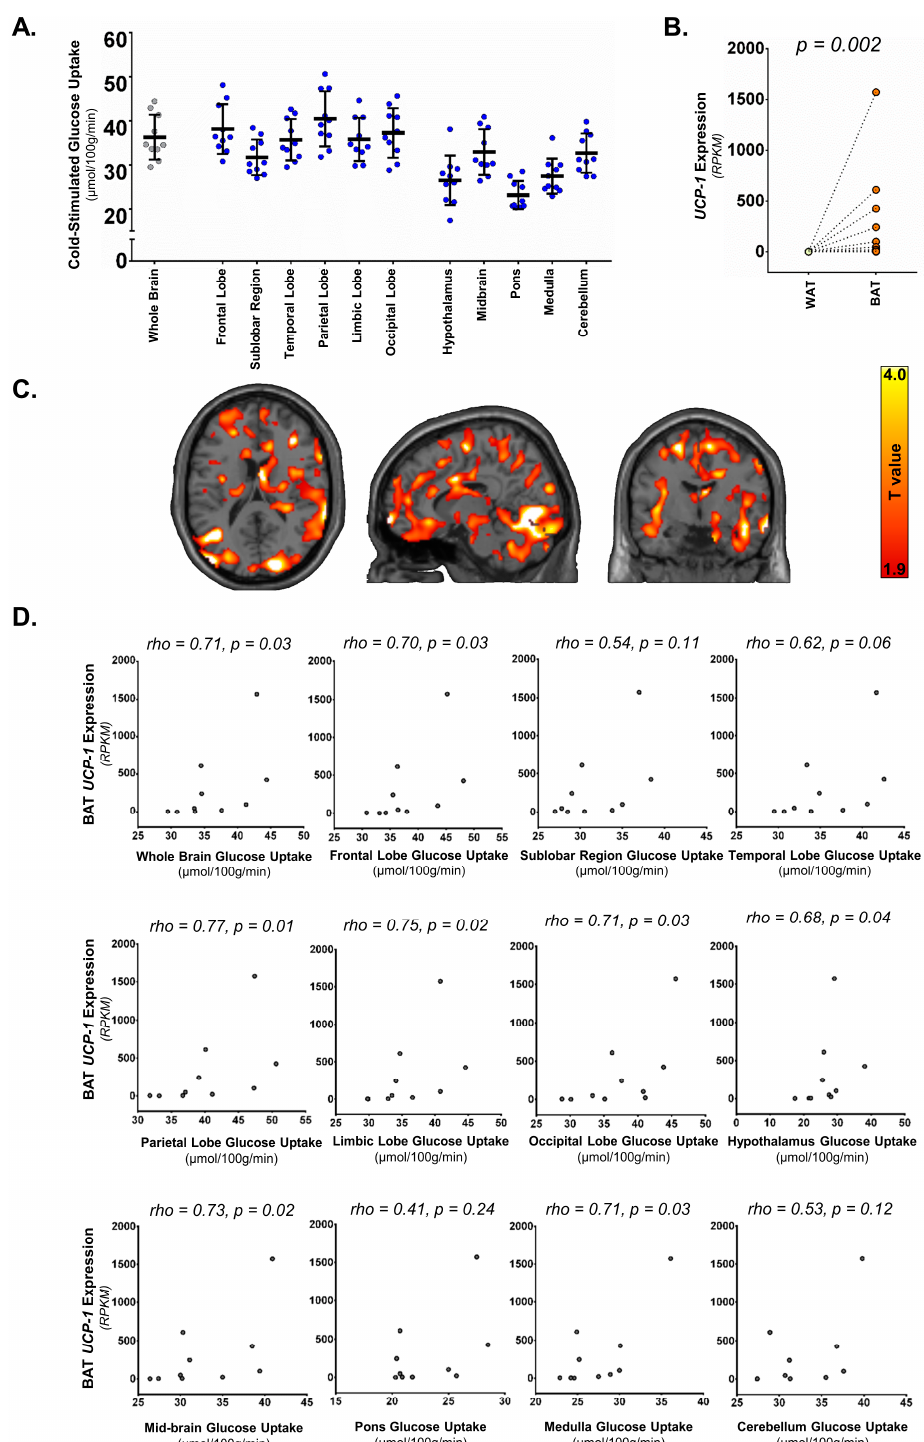
Figure 2. ( A ) Brain glucose uptake rate after a mild cold stimulus determined using 18 F-FDG PET imaging. ( B ) The expression of the UCP-1 gene in supraclavicular BAT and subcutaneous neck WAT. ( C ) Statistical parametric mapping (SPM) images of the association between brain glucose uptake (BGU) during cold conditions and BAT UCP-1 expression. p values < 0.05 cluster level; p values < 0.05 voxel level; extend threshold k = 114 voxels; FDR-corrected. Higher T values denote stronger associations (coloured bar at the side). ( D ) The relationship between UCP-1 expression in supraclavicular BAT and brain glucose uptake in the whole brain and different brain regions.